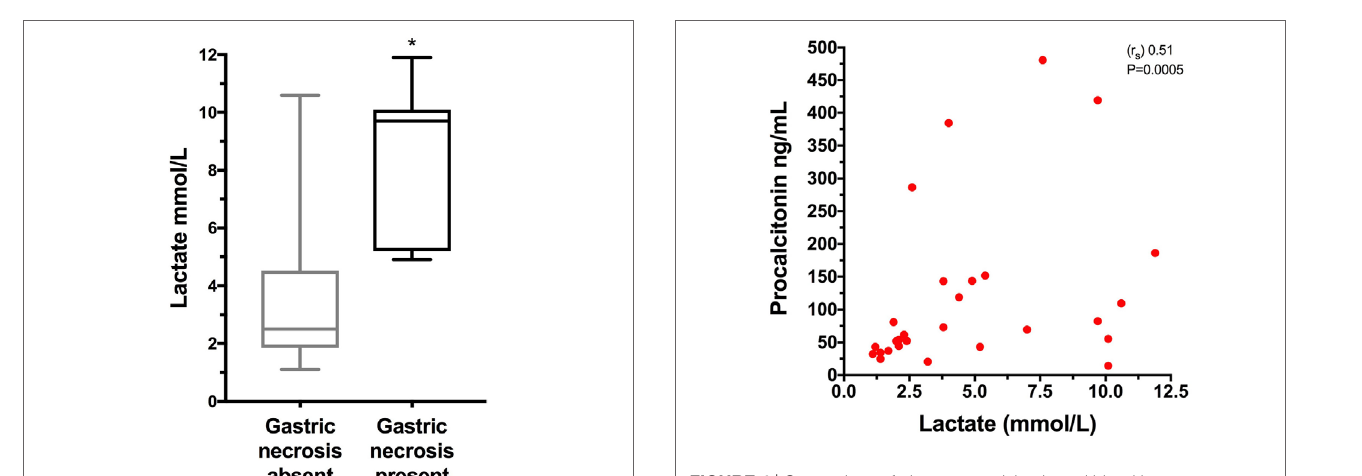
FigUre 4 | Comparison of plasma procalcitonin and blood lactate concentrations in 28 dogs with gastric dilatation–volvulus (GDV) syndrome. Spearman’s rank correlation coefficient ( r s ) 0.51, P =